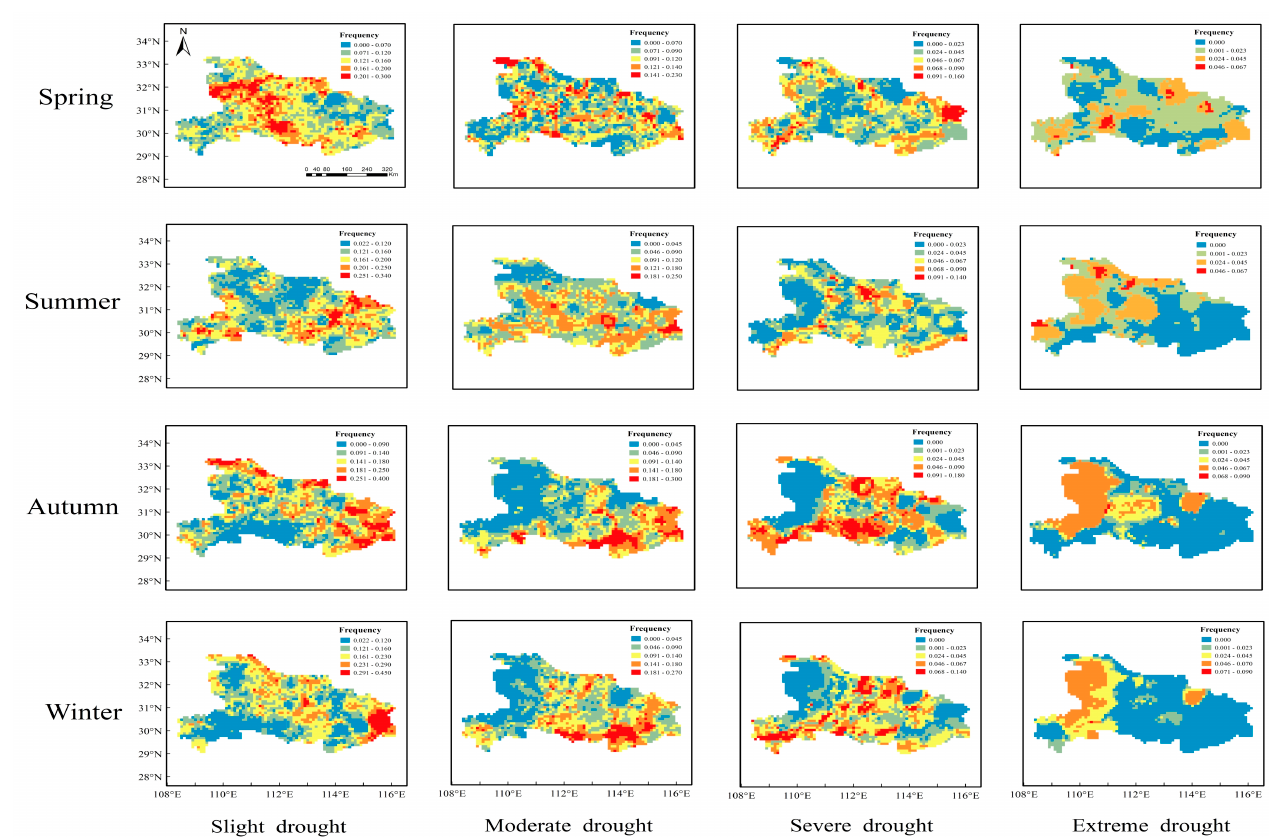
Figure 7. Seasonal drought frequency with different categories based on SPI-9.